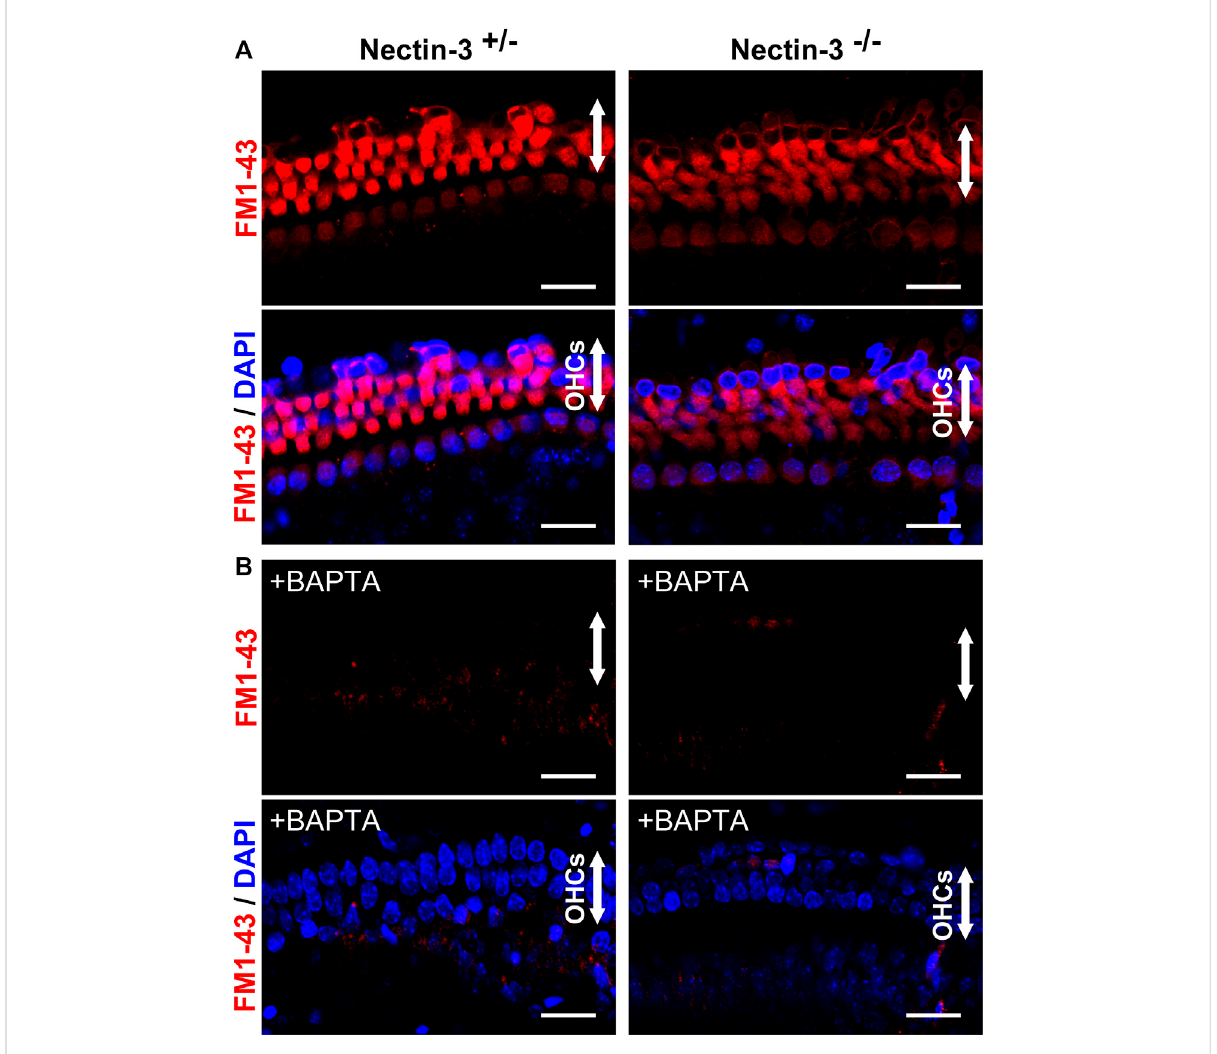
FIGURE 4 Mechanotransduction activity of neonatal nectin-3 KO mice (A) Fluorescence images of FM1-43 and DAPI of nectin-3 +/ – (left) or nectin-3 − / − (right) mouse cochlea, were exposed to 5 μ M FM1-43 for 10 s. Both nectin-3 +/ – and nectin-3 − / − mouse inner and outer hair cells showed robust uptake of FM1-43. The upper panels show the fl uorescent images of FM1-43, and the lower panels show the double fl uorescent images of FM1-43 andDAPI.Arrowsindicatetheouterhaircellregionoftheauditoryepithelia.Scalebarsare20 μ m. (B) FluorescenceimagesofFM1-43andDAPI of nectin-3 +/ – or nectin-3 − / − mouse cochlea, wereexposed to 5 μ M FM1-43 for 10 s with the treatment of 5 mM BAPTA. Nectin-3 +/ – and nectin-3 − / − mouse cochlea did not take up FM1-43. No remarkable differences were observed between nectin-3 +/ – and nectin-3 − / − mice. Scale bars are 20 μ